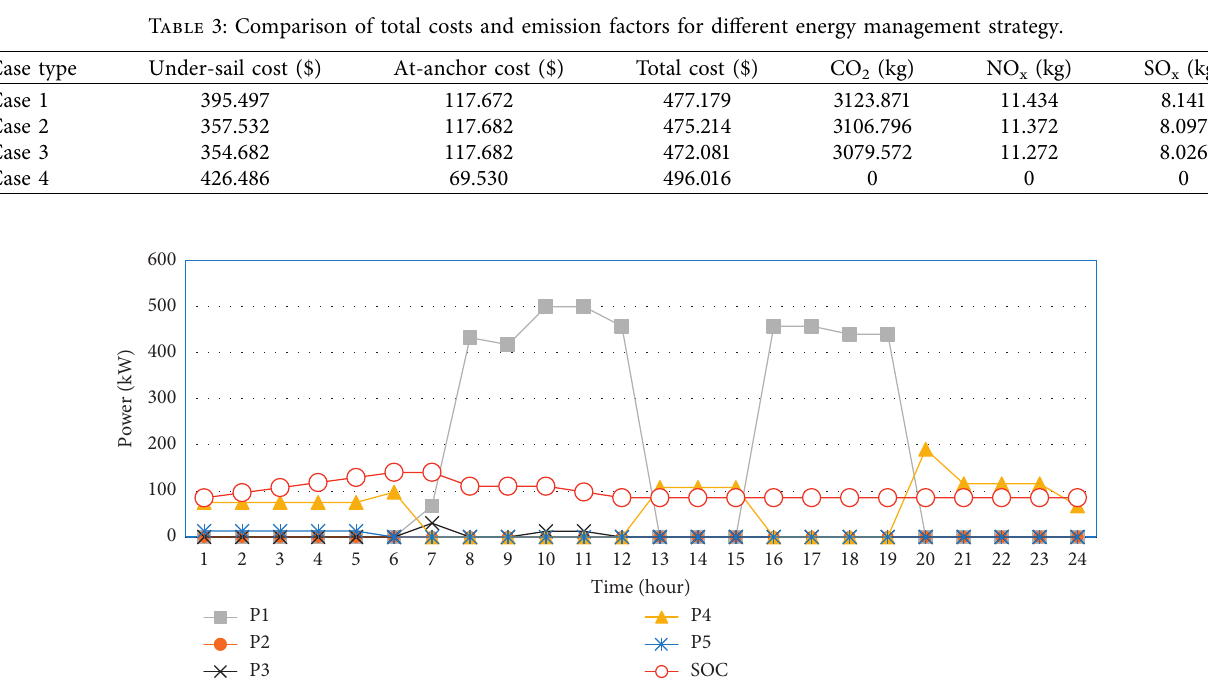
Figure 13: Hybrid energy management system rule-based method. Table 4: Total costs and emission factors for rule-based